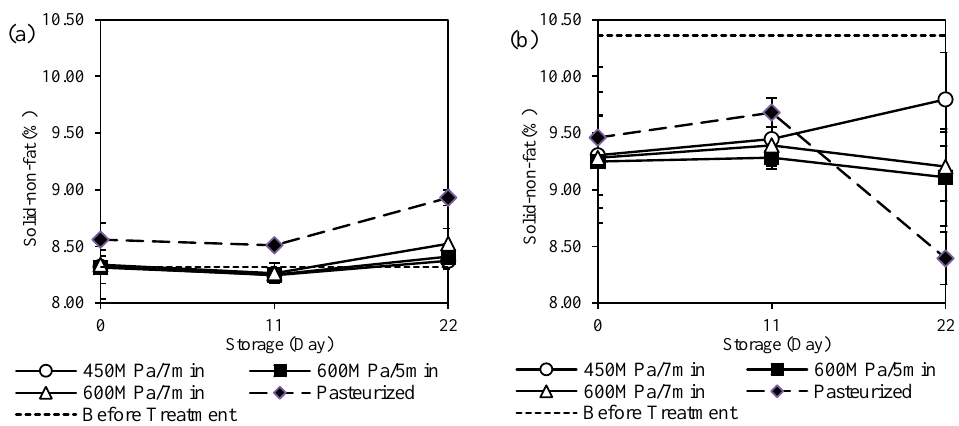
Figure 6. Changes in total solid of ( a ) cow and ( b ) goat milk during storage period of 22 days. Solid lines represent HPP-treated milk (450 MPa/7 min, 600 MPa/5 min, 600 MPa/7 min), dashed lines represent pasteurized milk, and dotted lines represent fresh milk before treatment.